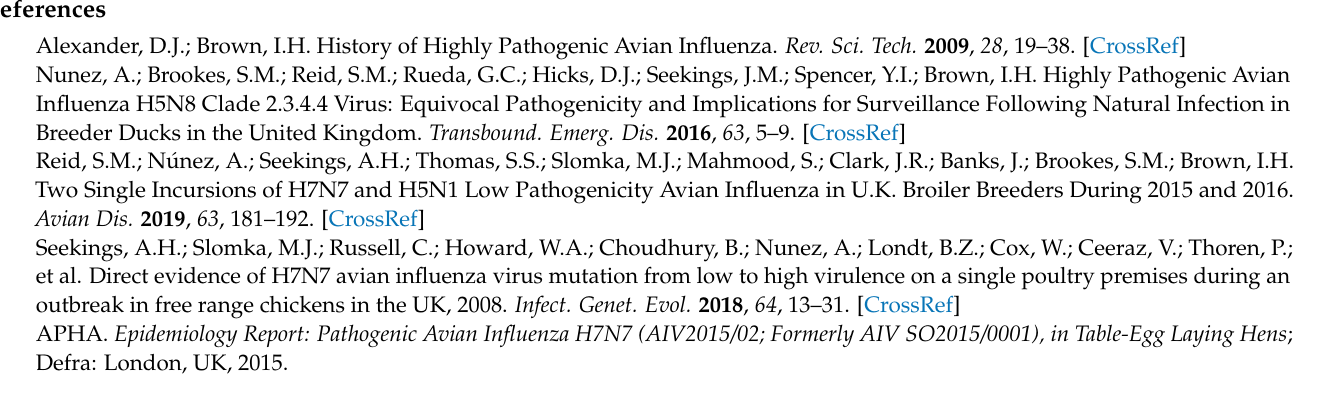
Sample Set 1. Table S3: Summary of the carcass tissues from Sample Set 3 with RRT-PCR results. Table S4: Summary of the type isolate viruses obtained from each shed in Sample Set 2. Table S5: Polymorphisms observed in A/chicken/England/26352/2015 that may confer adaptation to mammalian species or altered susceptibility to existing antivirals. Figure S1: Previous UK H7N7 outbreaks were also shed via the gastrointestinal route. Figure S2: A/chicken/England/26352/2015 is related to contemporary H7N7 or other wild bird AIVs from Europe. Figure S3: Sera from the outbreak demonstrated greater affinity to the H7N1 AIV